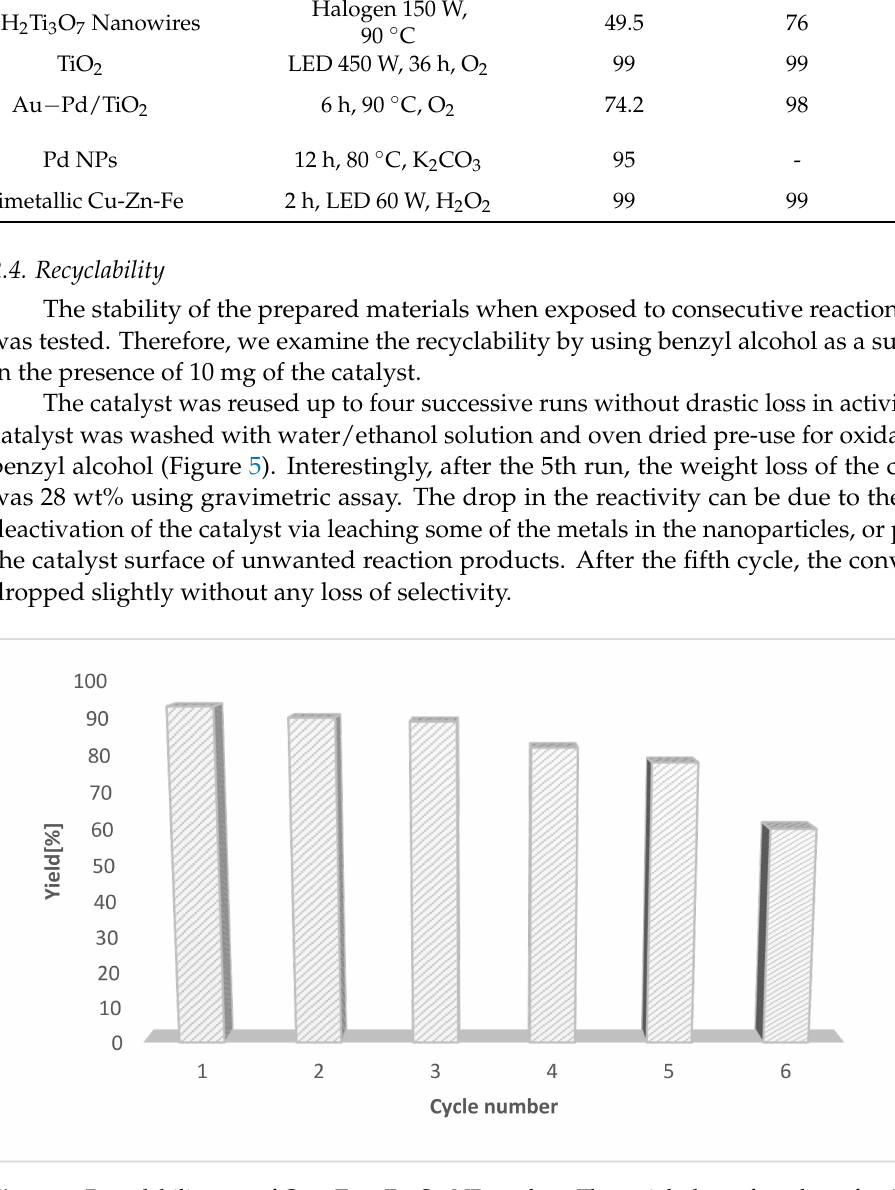
Figure 5. Recyclability test of Cu 0.5 Zn 0.5 Fe 2 O 4 -NP catalyst. The weight loss of catalyst after 5th runs was 28